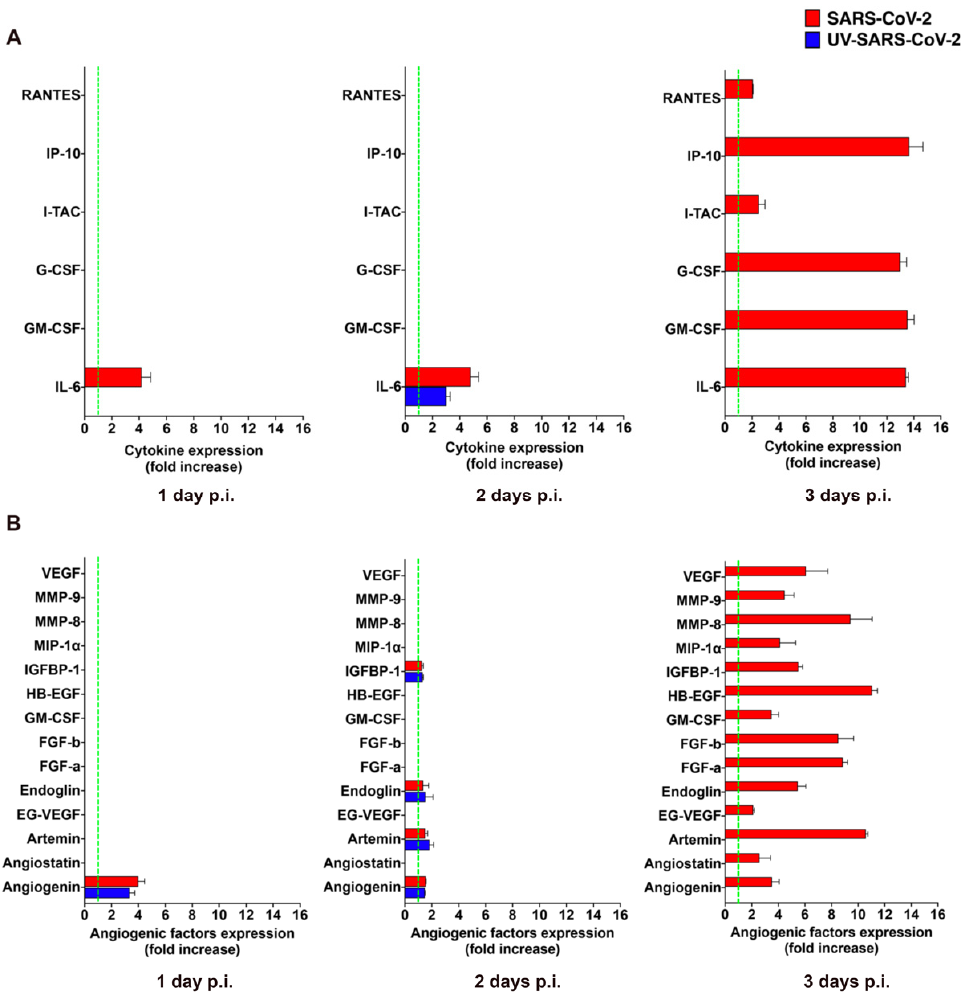
Figure 3. SARS-CoV-2 promotes the release of cytokines and angiogenic molecules from HL- mECs. HL-mECs were treated with infectious (SARS-CoV-2) or UV inactivated (UV-SARS-CoV-2) SARS-CoV-2 at MOI 1, for 1 h at 37 °C and then washed and cultured until day 3 p.i. Supernatants of SARS-CoV-2 and UV-SARS-CoV-2 HL-mECs were evaluated at 1 (left panel), 2 (middle panel), and 3 (right panel) days p.i. for the presence of ( A ) cytokines or ( B ) angiogenic molecules by human proteome arrays. The results are expressed as mean values ± SD of duplicates given as fold increase as compared to mock-infected cells. Data are representative of one out of three independent experiments with similar results.